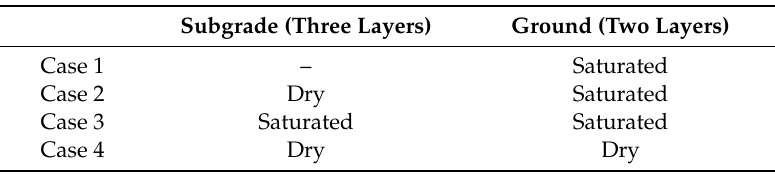
Table 5. Cases of multi-layered soils.